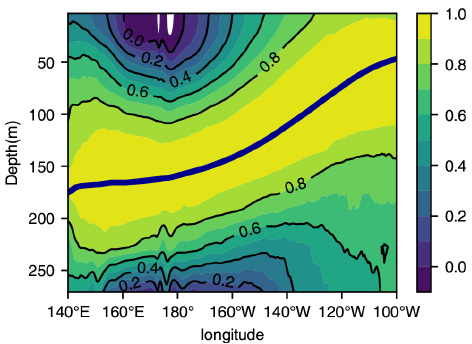
Figure 2. The correlation along the Equator between anomalies in D20 and potential temperature in the NEMO model simulation. The mean depth of D20 is shown by the thick, dark-blue line. Note that since we are at the Equator, variations in density are determined mostly by variations in potential